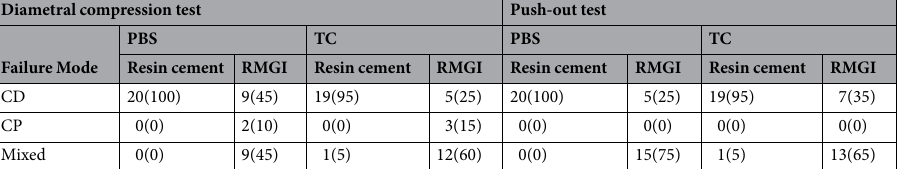
Table 2. Number (percentage) of specimens failed with a particular fracture mode under the different experimental conditions. CD: adhesive failure between the cement and dentin; CP: adhesive failure between the